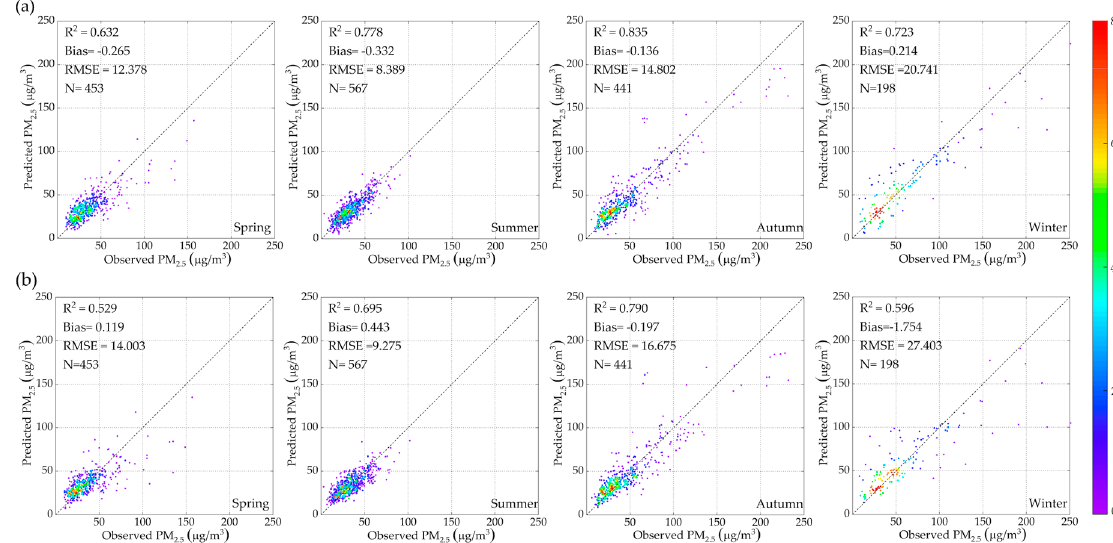
Figure 6. Seasonal comparisons of PM 2.5 concentrations predicted by the geographically weighted regression (GWR) ( a ) and generalized additive model (GAM) ( b ) vs. ground-based observations.